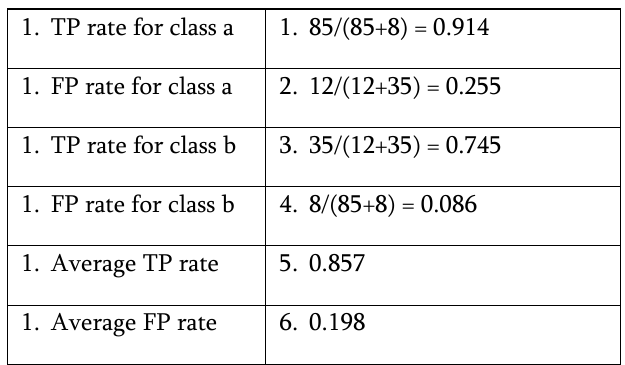
Table 6.2 Effectiveness of